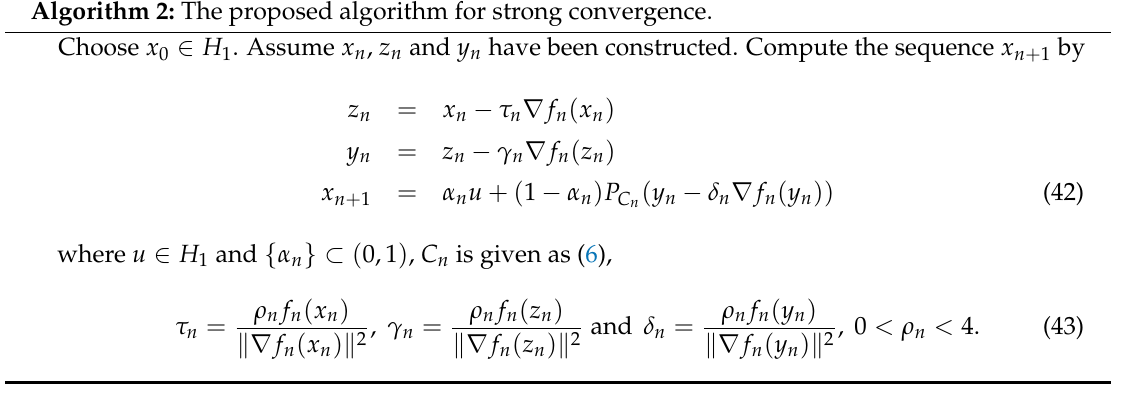
Algorithm 2: The proposed algorithm for strong